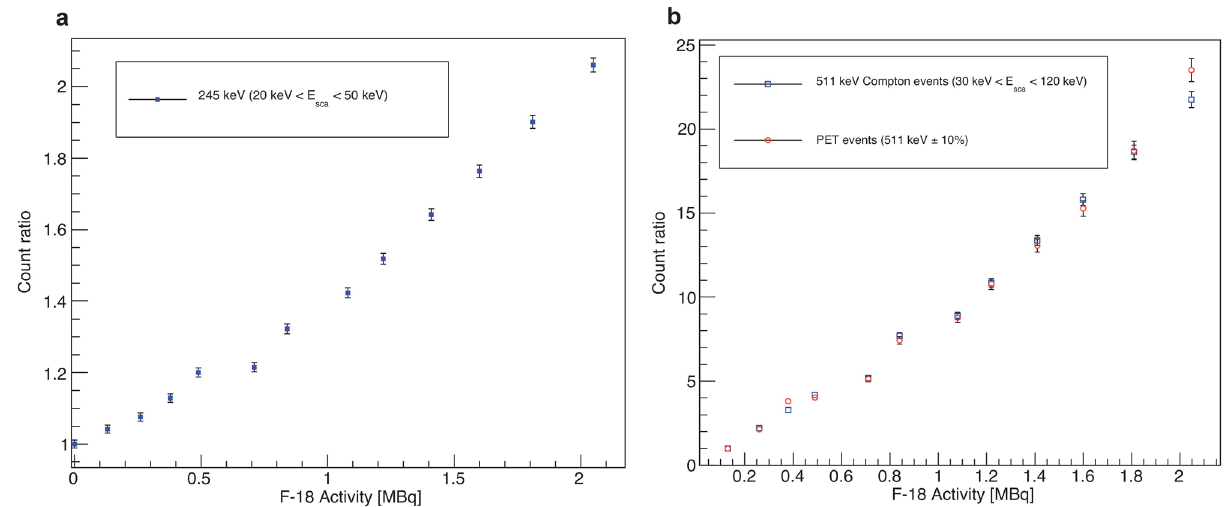
Figure 3. Relation between Compton events and 18 F radioactivity. (a ) Relation between the 245 keV Compton events used for Compton imaging and 18 F radioactivity. The y -axis represents the ratio of 111 In Compton events measured with 18 F to Compton events measured with no 18 F source. As the 18 F radioactivity increases, Compton events due to 245 keV gamma rays also increase. ( b ) Relation between Compton events (PET events) at 511 keV used for Compton imaging (PET imaging) and 18 F radioactivity. The y -axis is the ratio of Compton events (PET events) measured with various 18 F sources to Compton events measured with a 0.13 MBq 18 F source.